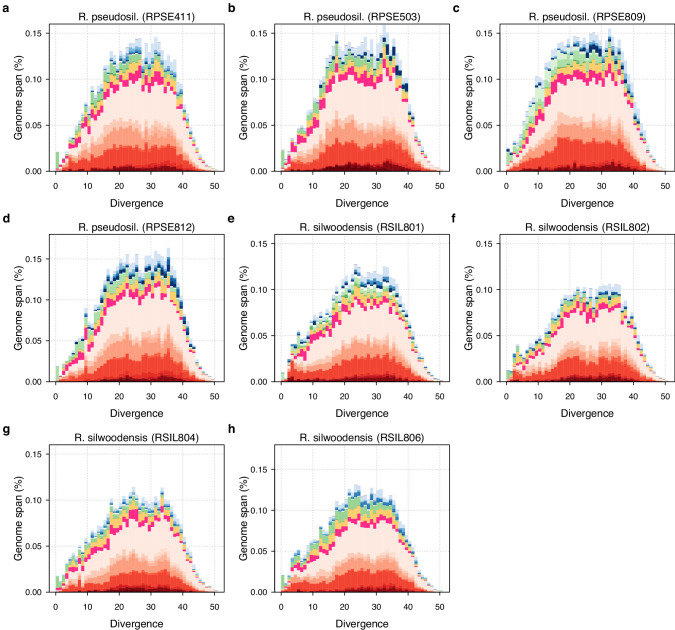
TE divergence landscapes for individual R. sp. ‘Silwood-1’ and R. sp. ‘Silwood-2’ genomes.